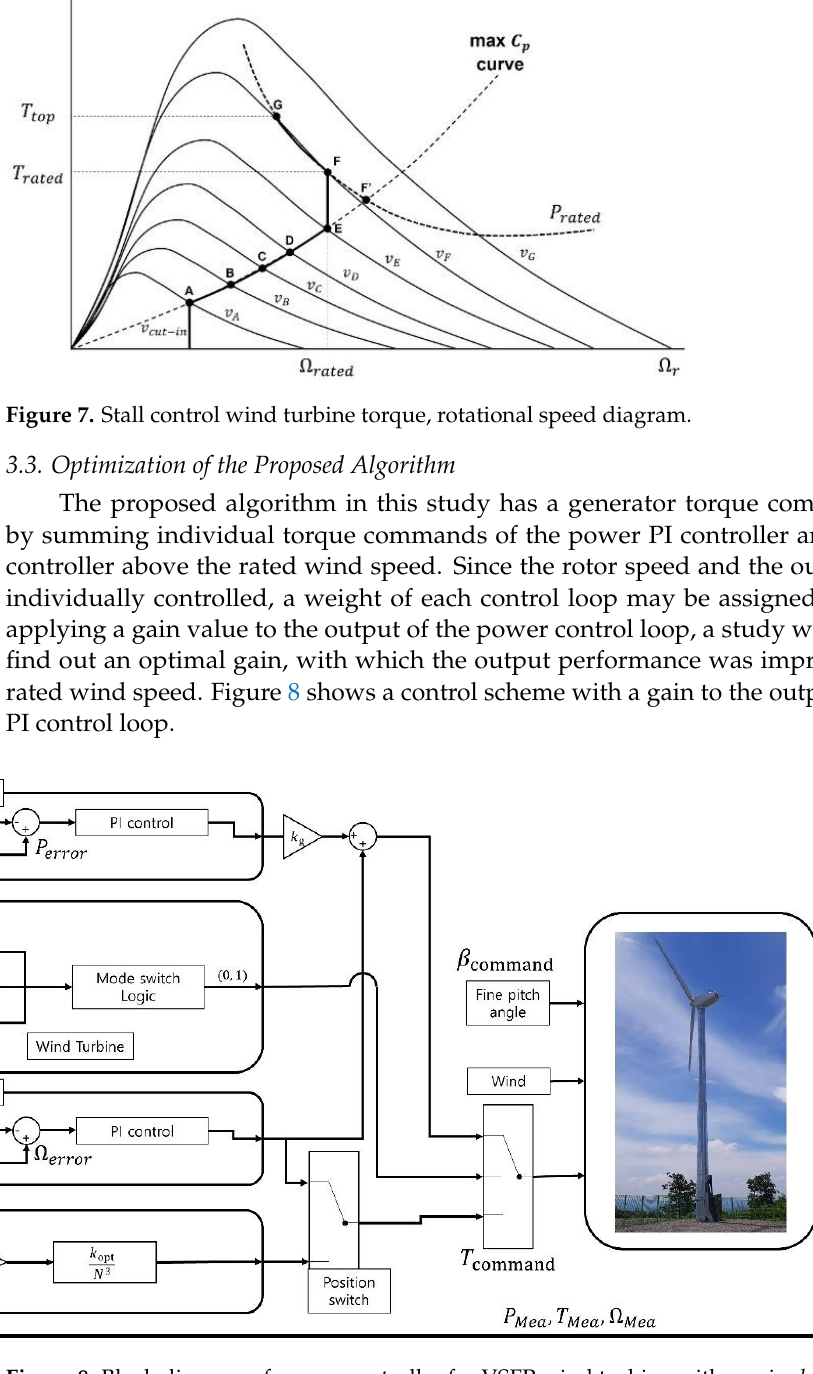
Figure 8. Block diagram of power controller for VSFP wind turbine with a gain, 𝑘 𝑔 .